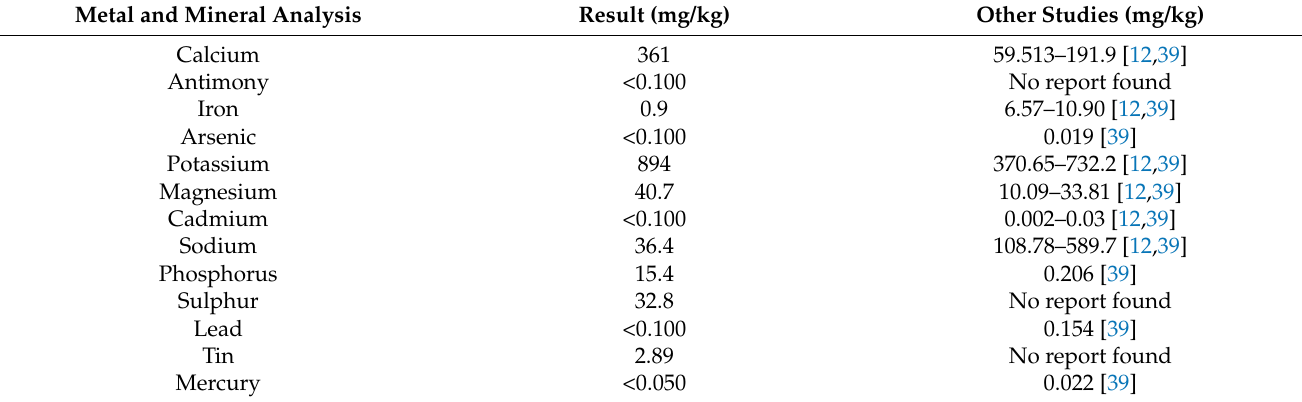
Figure 2. HPIC chromatograms of the sugar profile of KH. The retention times of the identified sugars were galactose, 8.4 min; glucose, 9.384 min; sucrose, 10.309 min; fructose, 12.250 min; lactose, 20.667 min; and maltose, 29.784 min. Table 5. Comparison of metal and mineral contents in our KH and other analyses.